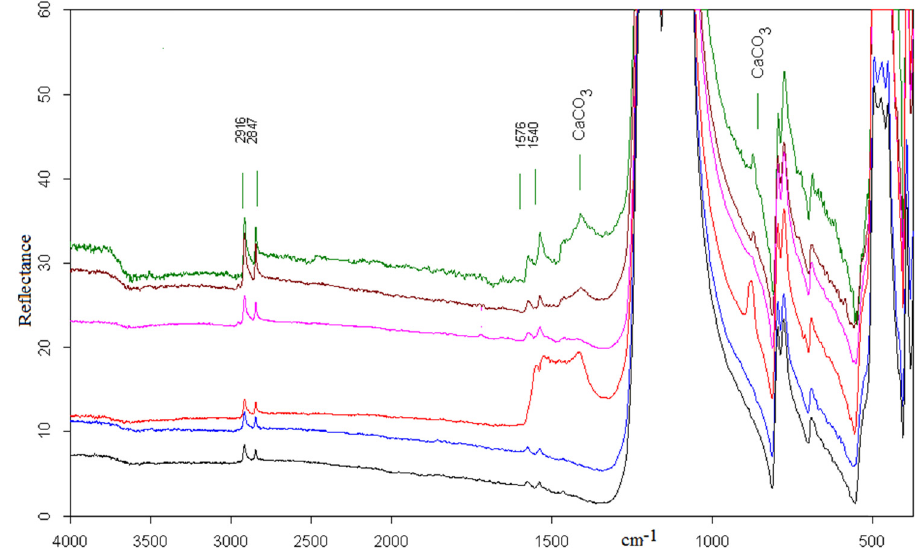
Figure 10: Micro FTIR spectrum of dorsal and ventral points of a scraper from building 32 ( FTIR spectra by S. Nunziante Cesaro )